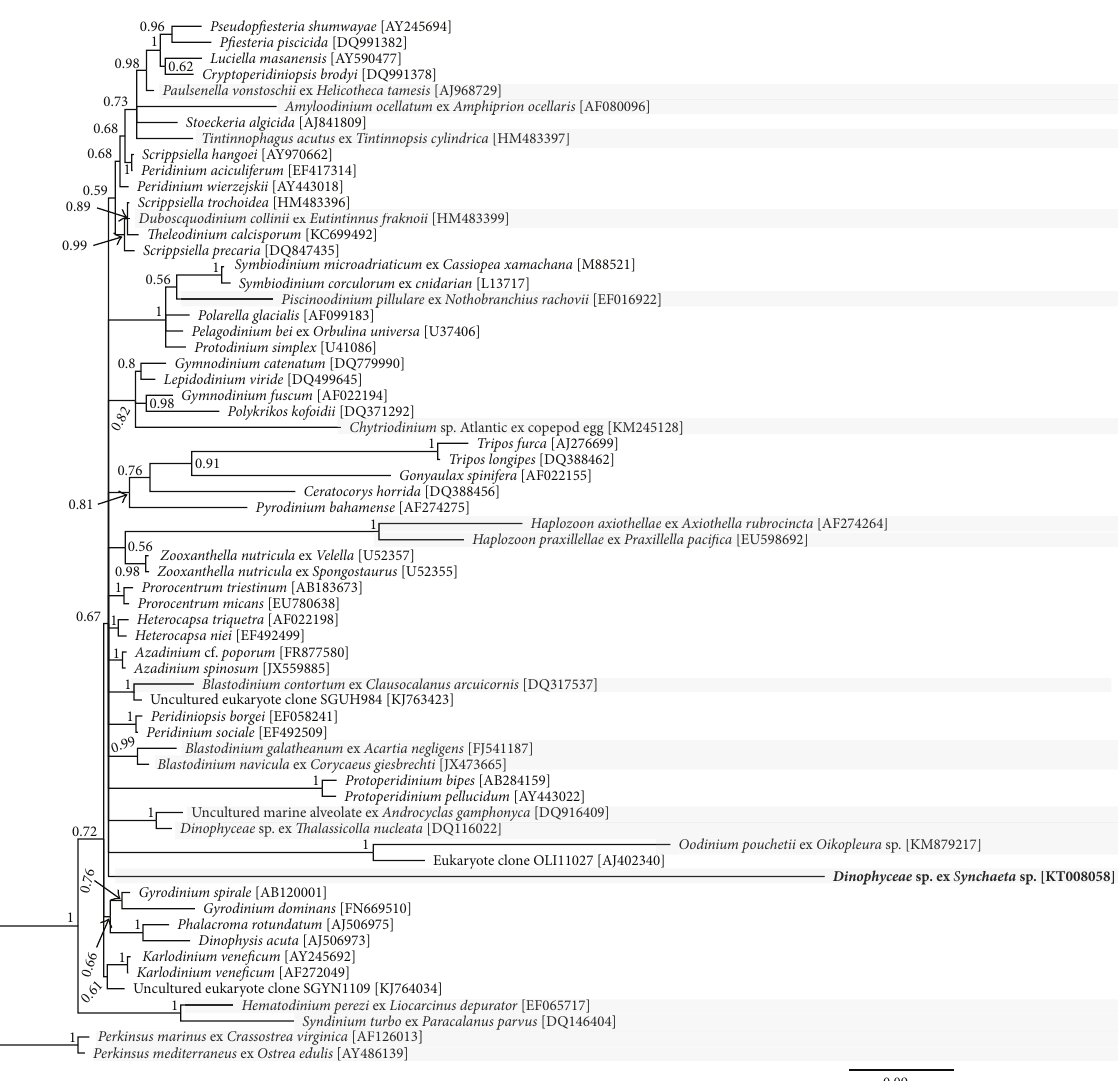
Figure 2: Phylogenetic tree of the dinoflagellates based on phylogenetic analysis of SSU rDNA sequences using Bayesian inference, based on 1,716 aligned positions. Perkinsozoa is used as outgroup. Parasitic taxa are highlighted. The species newly sequenced in this study are in bold. Posterior probabilities are given at nodes. The scale bar represents the number of substitutions per